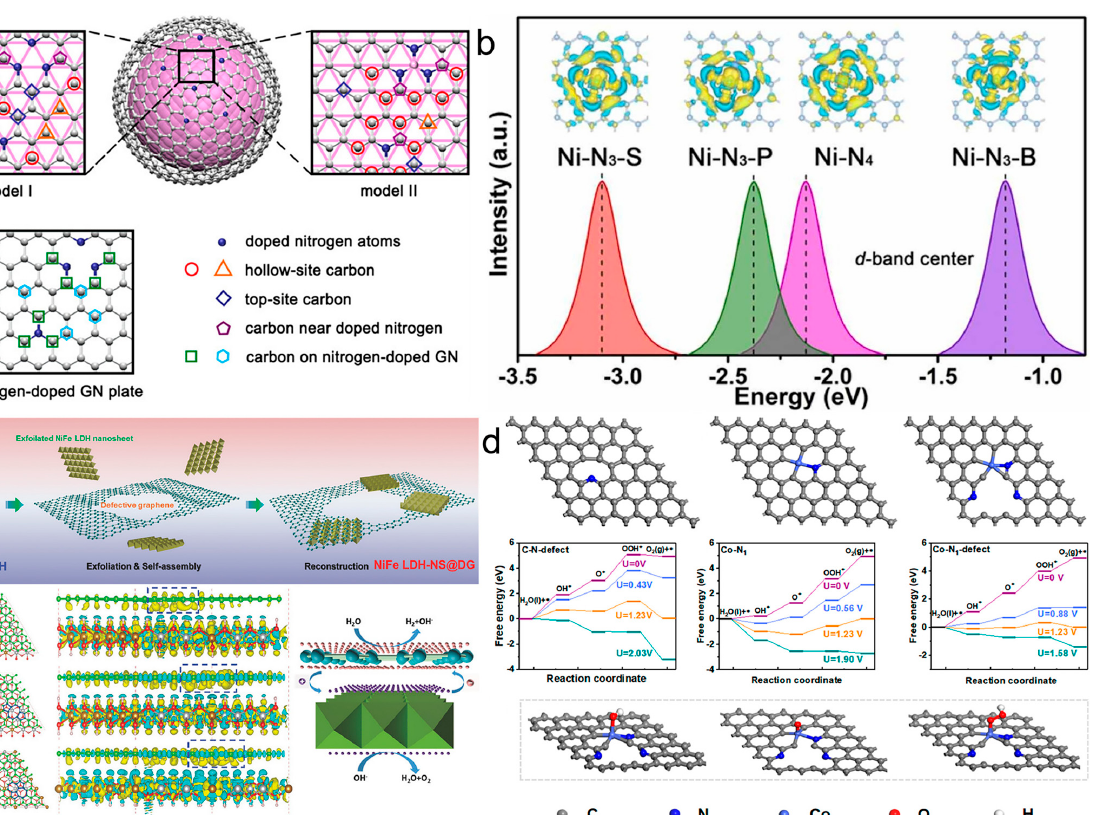
Figure 9. ( a ) Schematic diagram of Co, N − doped porous hollow carbon microspheres.